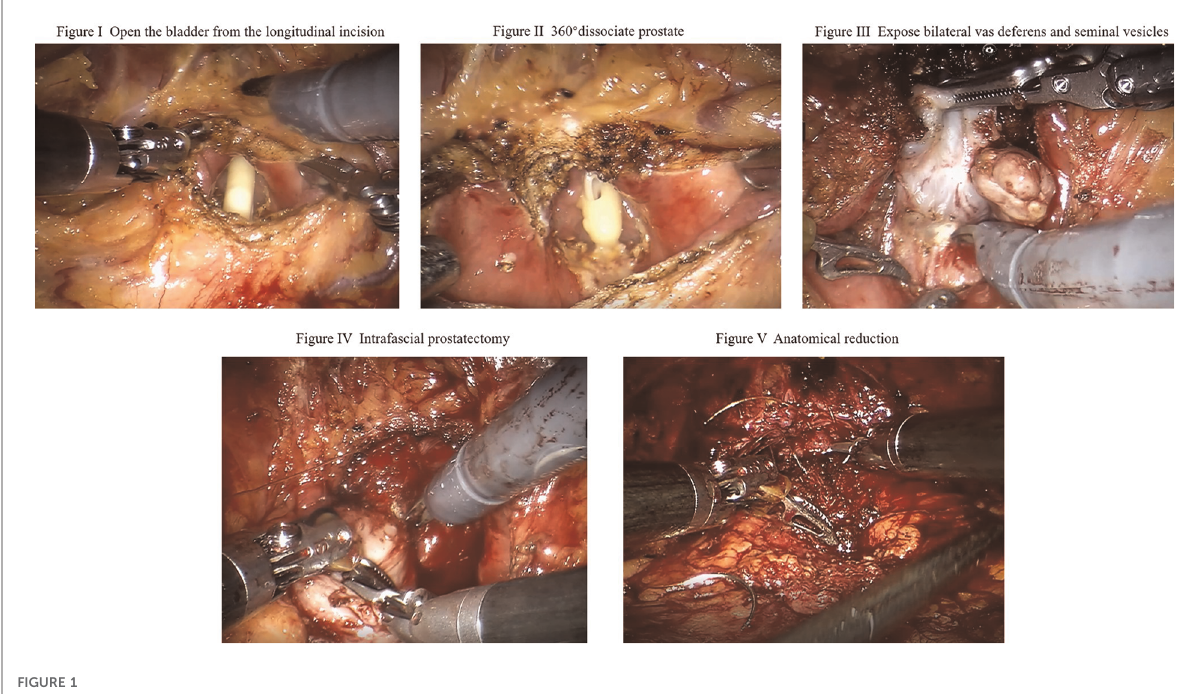
FIGURE 1 Surgical